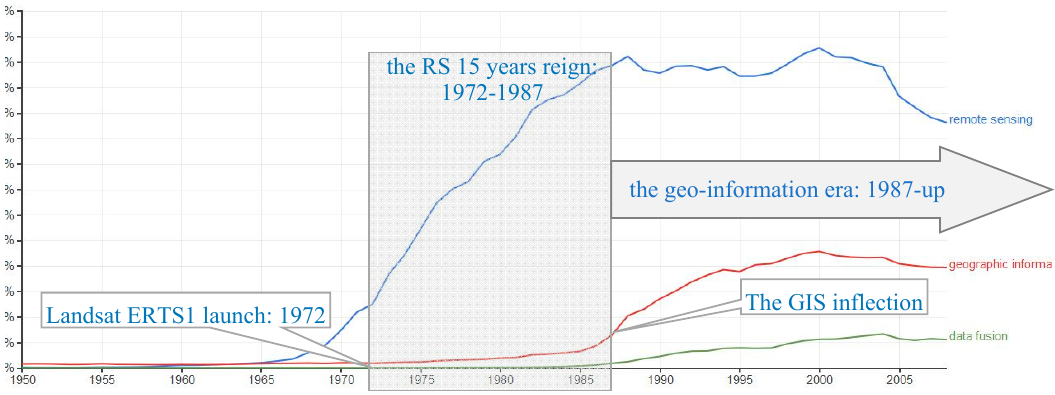
Figure 1. The “remote-sensing decade-and-a-half” and the beginning of GIS and data-fusion.